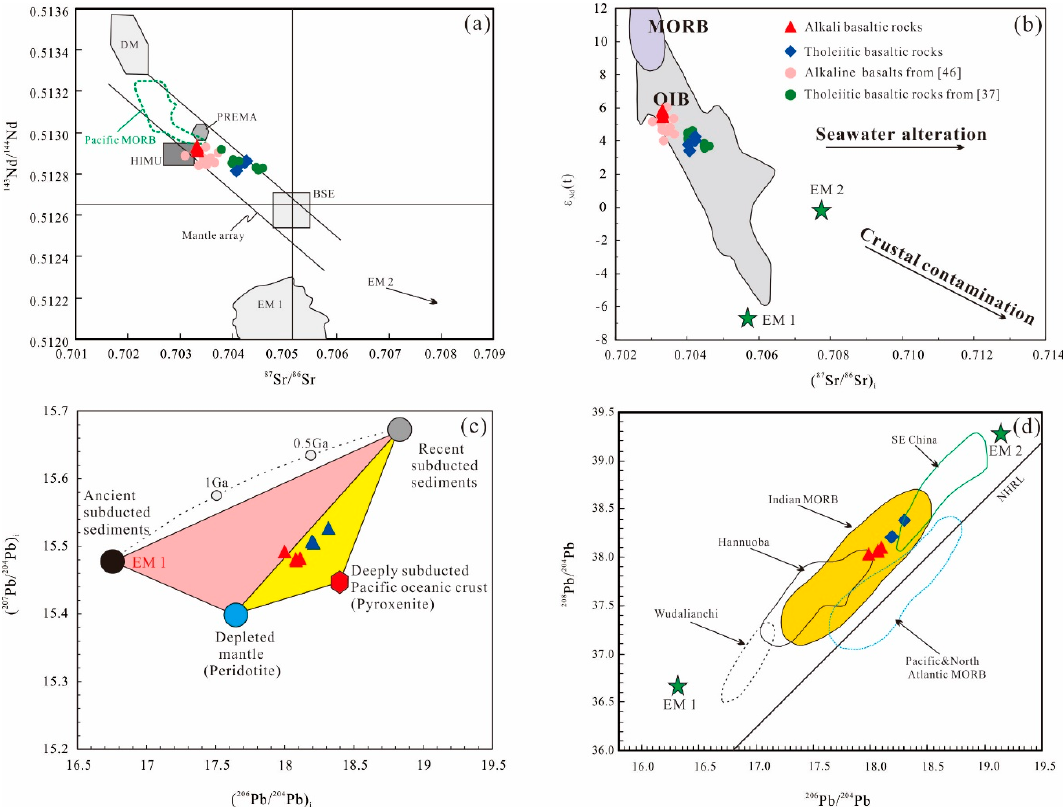
Figure 9. Whole-rock Sr–Nd–Pb isotopic compositions for the Cenozoic Qianjiadian mafic rocks. ( a ) 87 Sr / 86 Sr vs. 143 Nd / 144 Nd diagram; ( b ) ( 87 Sr / 86 Sr) i vs. ε Nd (t) diagram; ( c ) 206 Pb / 204 Pb vs. 207 Pb / 204 Pb; ( d ) 206 Pb / 204 Pb vs. 208 Pb / 204 Pb. DM, depleted mantle; EM-1 and EM-2, enriched mantle-1 and enriched